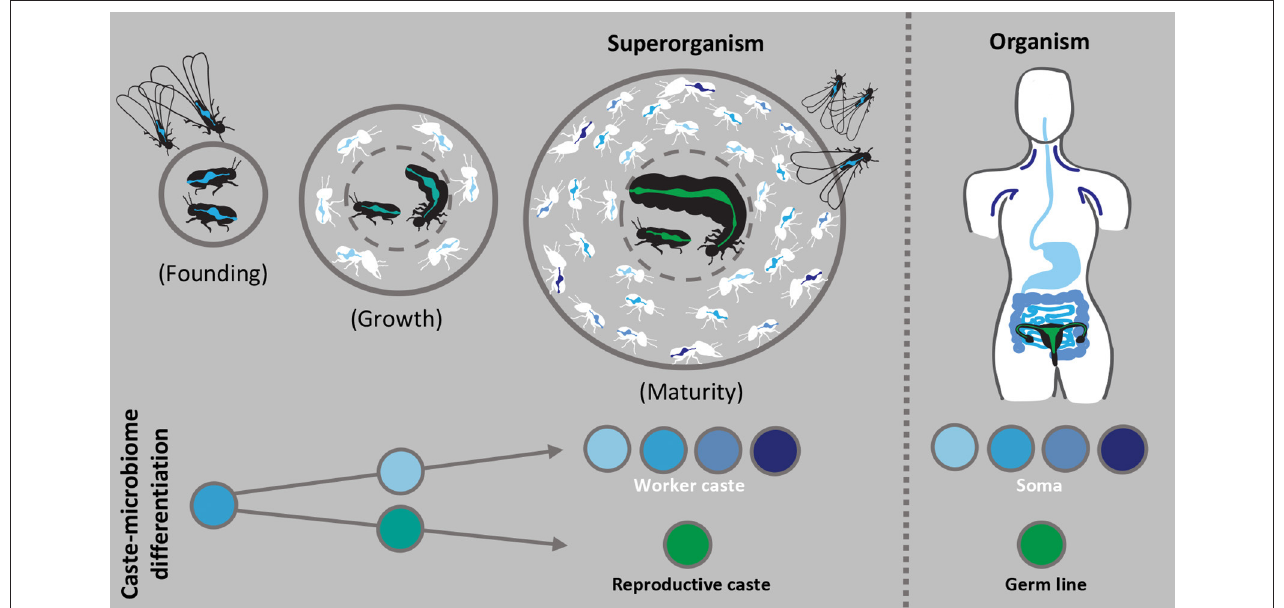
FIGURE 2 | Caste-specific microbiomes during growth and maturity of the superorganism. The left panel illustrates how gut microbiomes (spectrum of blue to green) of the reproductive (black) and worker caste (white) may structurally and functionally differentiate during the development of an independently founded colony. Such colonies undergo ergonomic growth before reaching maturity, during which caste roles establish and gut microbiota may similarly diverge. Reproductive gut microbiota (green) likely simplifies in structure and function while worker microbiota (blue) remains relatively diverse and may be partitioned among subcastes. The right panel proposes that the general structure and function of the superorganism microbiota could be analogous to that of multicellular organisms, in this case microbiota of human tissues. The major transition to superorganismality causes selection to act on the colony as a unit, similar to an individual organism, and the binary distinction between the worker and reproductive caste is comparable to the soma and germ line. Greater understanding of the cohesive actions carried out by the divisible units of superorganisms and their microbial partners may allow us to derive novel insights into higher-level emergent characteristics typically associated with and observed in